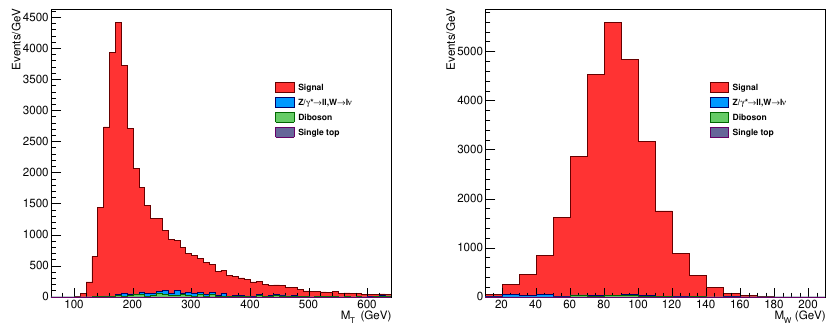
Figure 5 . Reconstructed M T (left) as well as M W (right), for a sample of signal (top pairs) and background events corresponding to an intergrated luminosity of 50 fb − 1 at 13